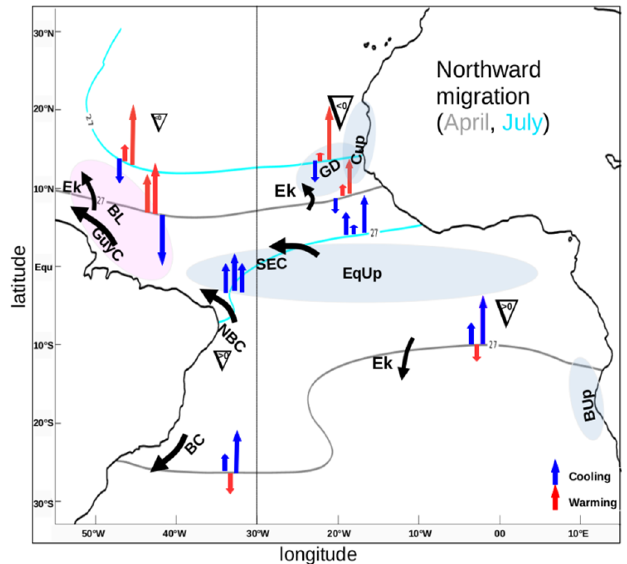
Figure 7. Schematic representation of the AWP northward migration mechanism during boreal Spring (April, grey contour) and Summer (July, cyan contour). Meridional linear velocities (vectors) grouped by three which add up to V *, V oce-ver (left arrow), V ocea-lat (middle arrow), and V air-sea fluxes (right arrow). Northward (southward) arrows represent positive (negative) velocities and their color reminds the sign of the heat flux: warming (red) and cooling (blue). The amplitude of the meridional SST gradient is represented by the gradient symbol. BL: barrier layer, GD: Guinea Dome, SEC: South Equatorial Current, Ek: Ekman transport, GuyC: Guyana Current, NBC: North Brazil Current, and SBC: Southern Brazil Current. Cup: Canary Upwelling System, EqUp: Equatorial Upwelling, and BUp: Benguela Upwelling system.